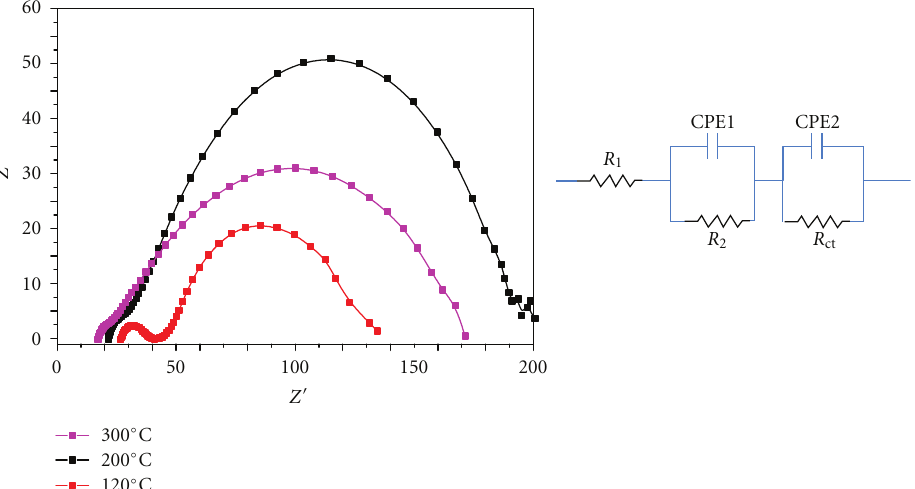
F 7: EIS spectra showing Nyquist plots of the MPTS/TiO the equivalent